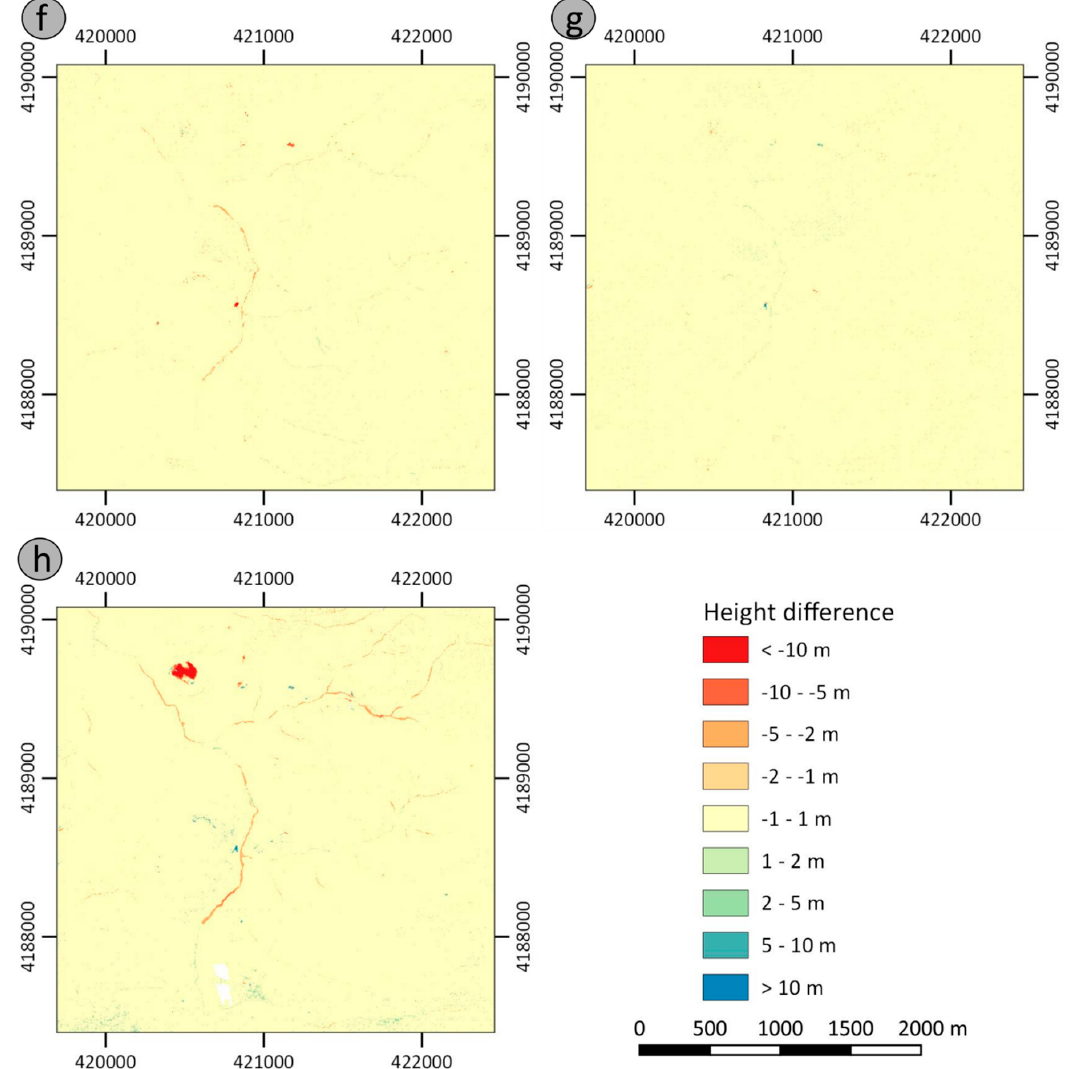
Figure 6. (continuation). DSMs of differences (DoDs) of the whole area: ( f ) period 2011–2013; ( g ) Figure 6. DSMs of di ff erences (DoDs) of the whole area: ( a ) period 1980–1996; ( b ) period 1996–2001; period 2013–2016; ( h ) complete period (1980–2016). Coordinates are in ETRS89/UTM30. ( c ) period 2001–2005; ( d ) period 2005–2009; ( e ) period 2009–2011. Coordinates are in ETRS89 / UTM30; DSMs of di ff erences (DoDs) of the whole area: ( f ) period 2011–2013; ( g ) period 2013–2016; ( h ) complete period (1980–2016). Coordinates are in ETRS89 /